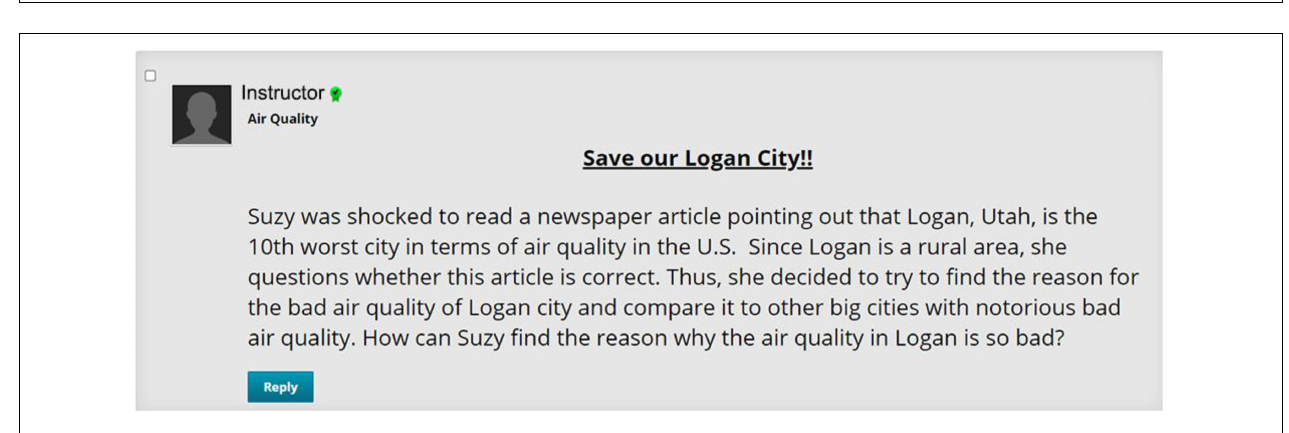
FIGURE 1 | Strategic and conceptual scaffolding from GPT-2 Algorithm.